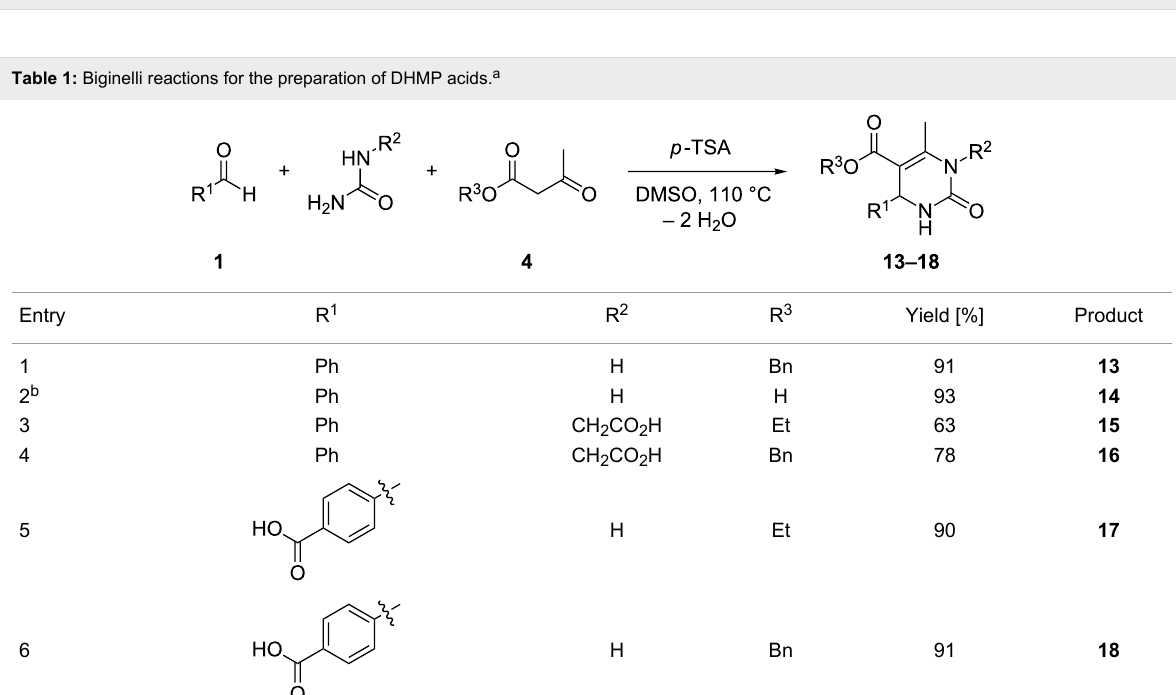
Figure 1: Bifunctional components for the Biginelli–Passerini tandem reaction.